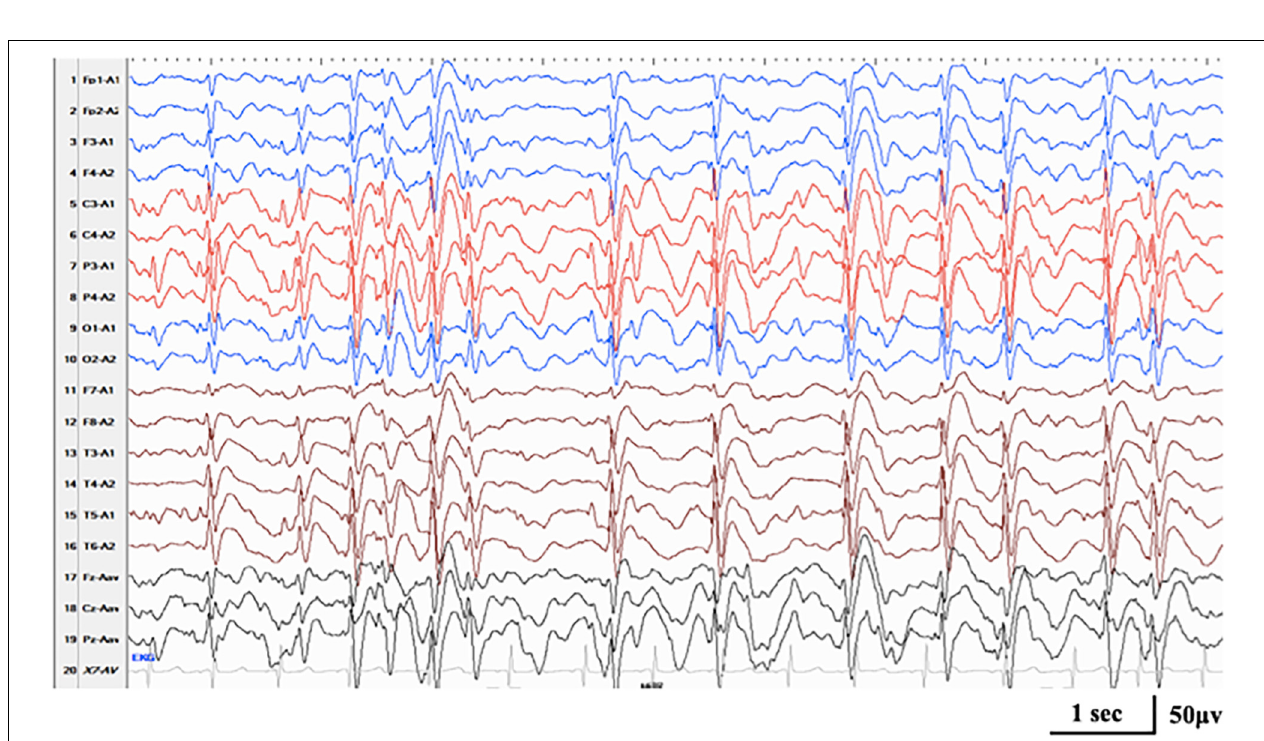
FIGURE 4 | Interictal EEG in case 17 with RARS2 -related disorders at the age of 3.5 years, demonstrating generalized spike-and-wave with Rolandic predominance during NREM sleep (SWI 85%).